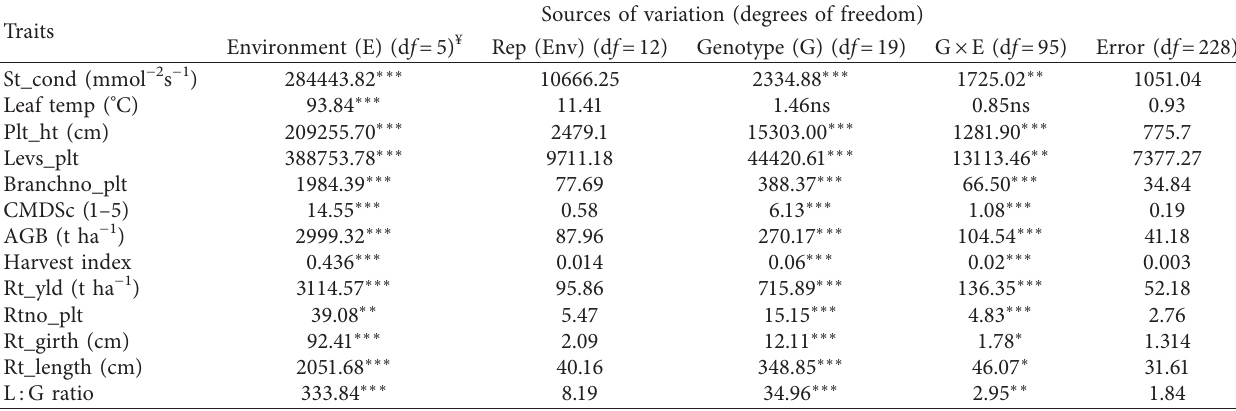
Table 6: Combined analysis of variance for physiological parameters, growth parameters, root yield, and yield components of 20 cassava genotypes in six environments.